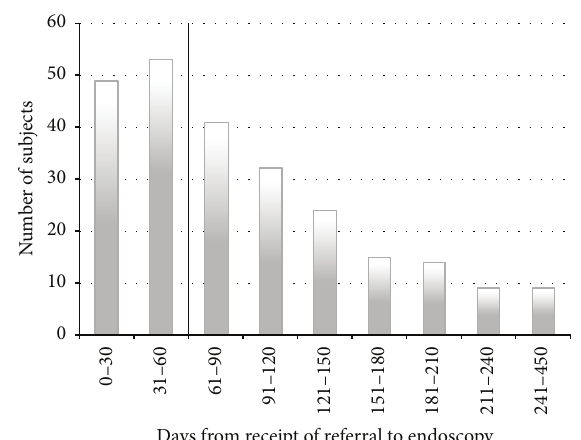
Figure 1: A frequency histogram of wait-time in days from receipt of referral to endoscopy in all included subjects ( 𝑁 = 246 ) is shown in the figure. Wait-times are shown in 30-day intervals with the exception of the last bar (241–450 days). The 60-day benchmark appears as a vertical line at the 60-day mark. 102 of 246 subjects (41%) had their first endoscopic procedure within 60 days; wait- times ranged from 1 to 428